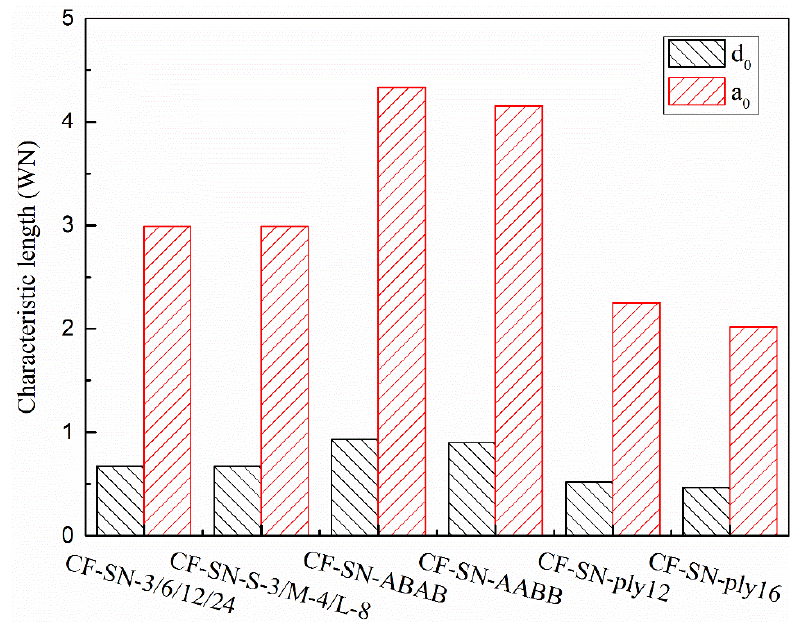
Figure 20. Average characteristic lengths, d 0 and a 0 , of each type of specimen (equal specimen size group/equal ratio of W /2 C group/CF-SN-ABAB/CF-SN-AABB/CF-SN-ply12/CF-SN-ply16) calculated by the WN stress criteria; both the lay-up sequence and layer number affect the character- istic